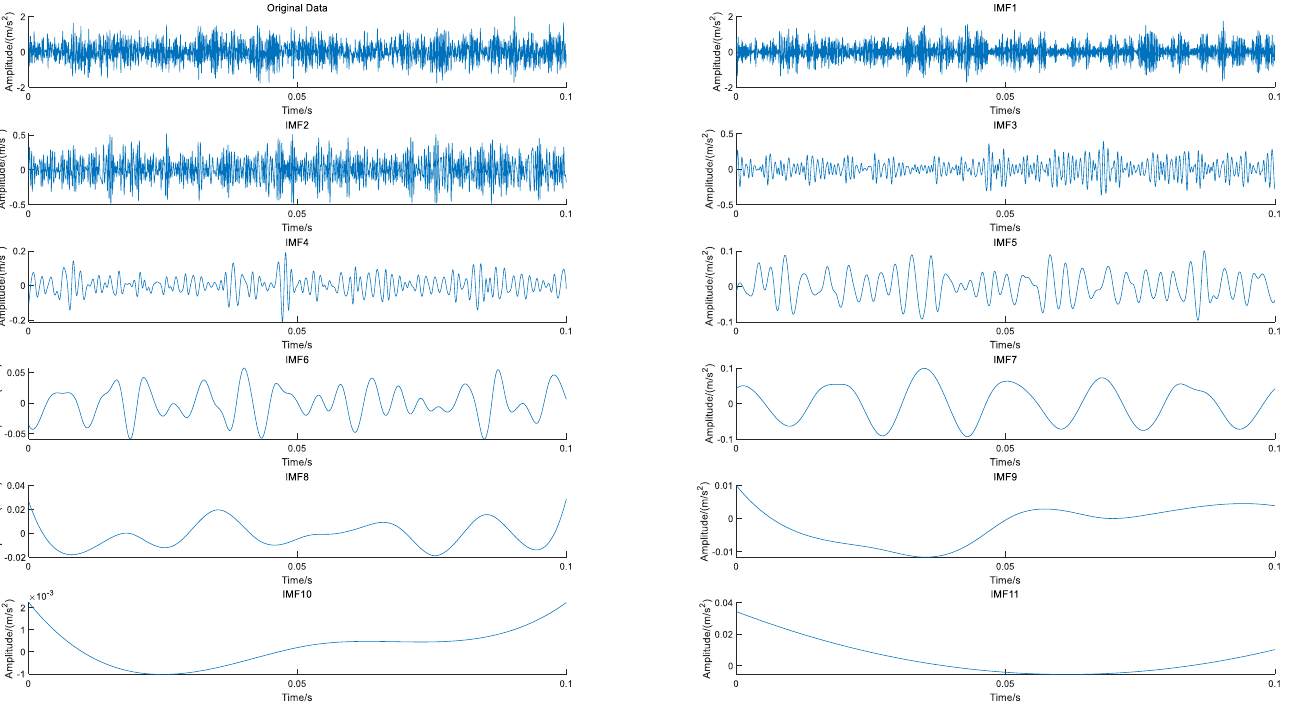
Figure 8. Original signal and EEMD decomposition results.